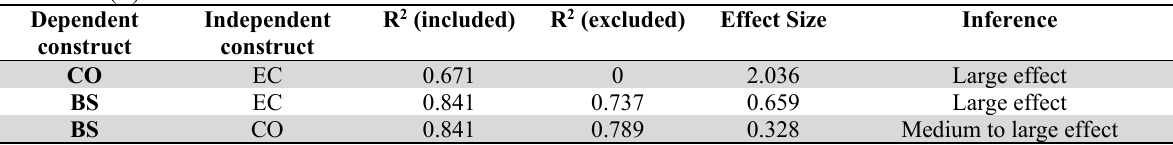
Effect Size (f 2 )